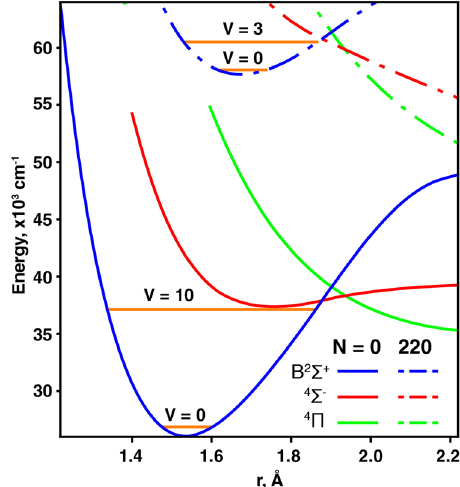
Fig. 5 Using super rotors to probe molecular structure far from equilibrium. MRCISD + Q/aug-cc-pwCV5Z potential energy curves (see Supplementary Information Section 5 for details) for SiO + at N = 0 and at N = 220, the latter altered signi fi cantly by centrifugal distortion. The B 2 Σ + vibrational levels v = 0 and v near the 4 Σ − state crossing (at around r = 1.9 Å for both N ) are Ba + and SiO + samples were loaded into the trap by means of ablation with the 532 nm Nd:YAG Minilite laser. Ba atoms were directly photoionized at 237nm while SiO molecules were photoionized using a 1 + 1 REMPI process via the 5 – 0 band of the A – X transition of SiO at 214nm 41 . Photoionization UV light was generated with a tunable EKSPLA OPO system. 138 Ba + ions were Doppler cooled by optical pumping via the 6 2 S 1/2 – 6 2 P 3/2 transition at 493nm and repumping the 5 2 D 3/2 “ dark ” state via the 5 2 D 3/2 – 6 2 P 3/2 transition at 650nm with continuous wave diode lasers. The translational temperature was suf fi ciently reduced so that the ions formed ordered structures known as Coulomb crystals. Since the effective trap potential is inversely proportional to the ion ’ s mass, the Coulomb crystal that we observed on CCD camera had a dark core formed by SiO + ions and surrounded by bright Ba + ions. SiO + reacts with the background gas comprised mainly of H 2 molecules, which are present in our UHV system at densities of ~10 7 cm − 3 . The SiOH + molecules formed in the reaction stay trapped, and the LCFMS peaks of SiOH + and SiO + overlap. The SiO + lifetime in the trap is reaction-limited to 10-20 min. To avoid